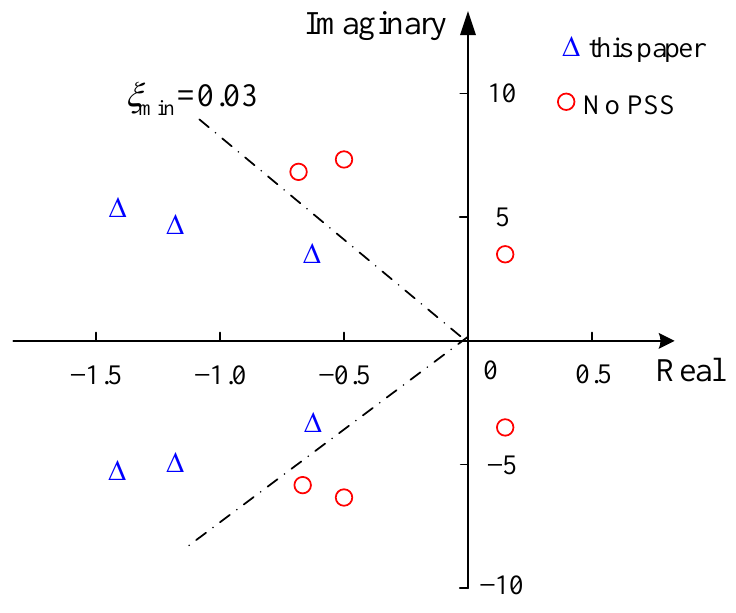
Figure 10. Distribution of eigenvalues.